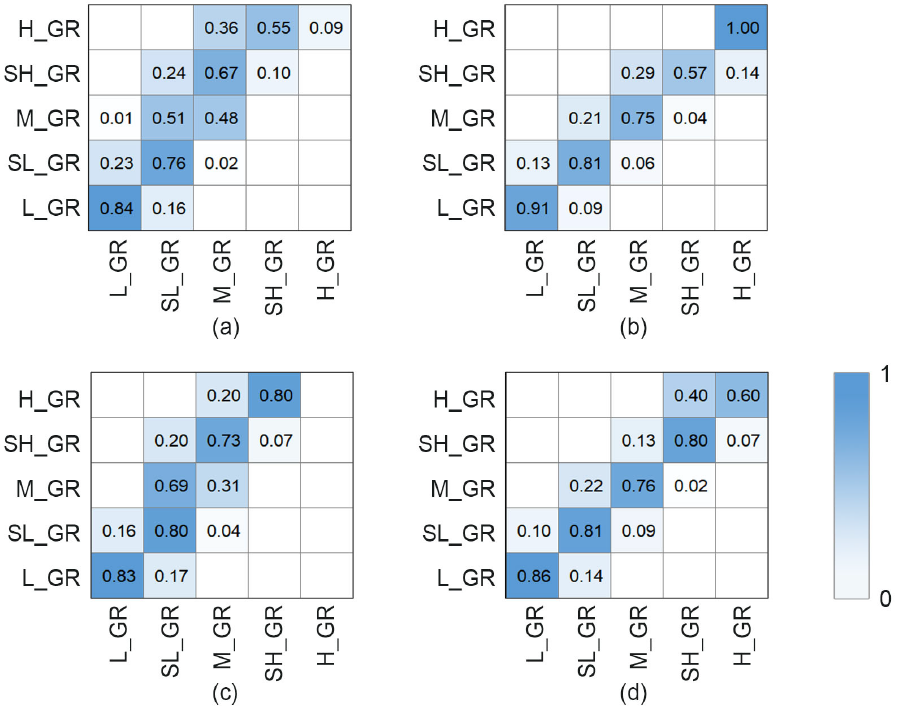
Figure 4. The confusion matrices of 150 m and 180 m fishnets: ( a ) comparison of GF1 and DJI in the 150 m fishnet; ( b ) comparison of GF1 and S2A in the 150 m fishnet; ( c ) comparison of GF1 and DJI in the 180 m fishnet; ( d ) comparison of GF1 and S2A in the 180 m fishnet.